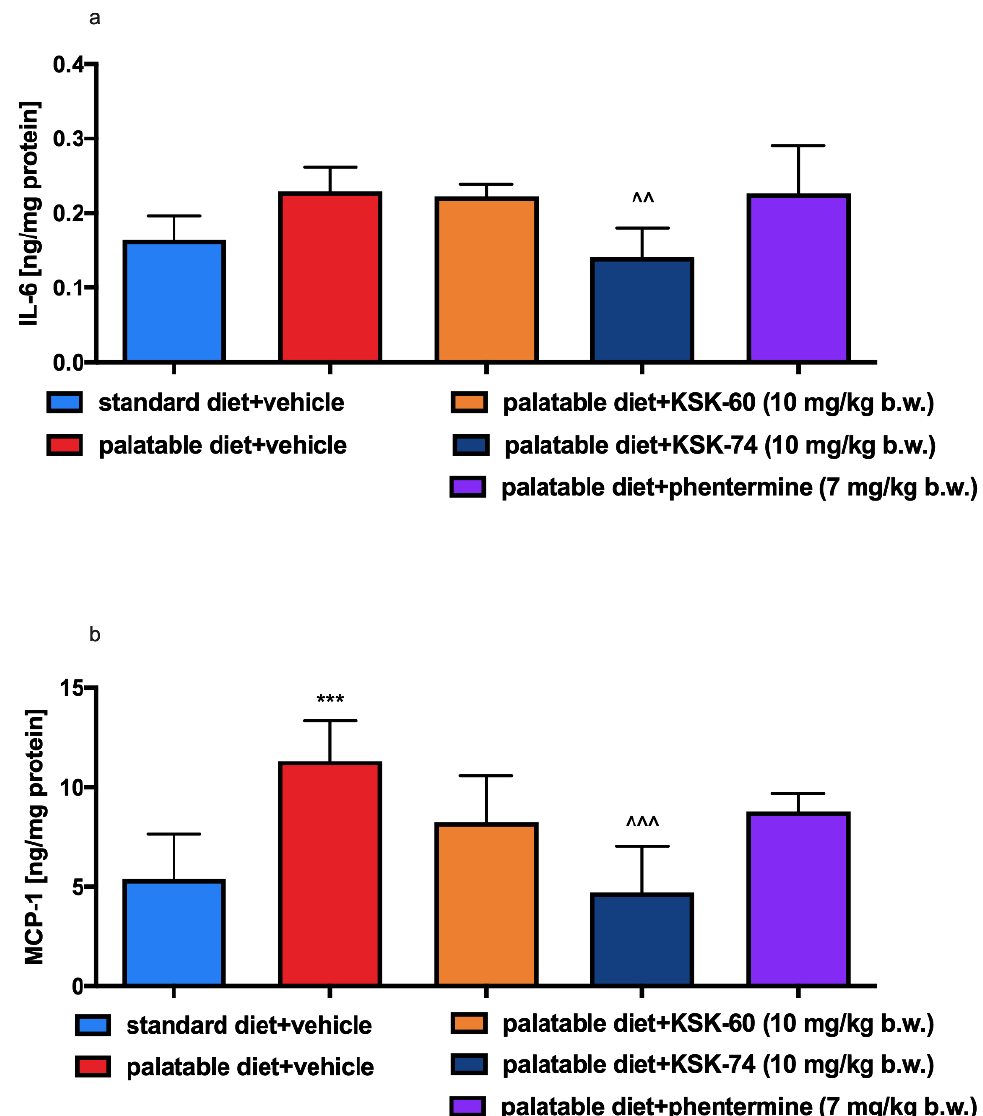
Figure 10. Effect of administration of the tested compounds or phentermine on adipose tissue levels of ( a ) IL-6 and ( b ) MCP-1. Results are expressed as means ± SD, n = 6. Comparisons were made using one-way ANOVA, Tukey’s post hoc test; * significant vs. standard diet + vehicle group; ^ significant vs. palatable diet + vehicle group ^^ p < 0.01, ***, ^^^ p < 0.001. There were significant changes in leptin and resistin levels in adipose tissue between rats in control groups that received different diets (standard or palatable) and vehicle ( p < 0.05, Figure 11a,b). Compared to the palatable diet + vehicle group, reduced levels of leptin and resistin were observed in adipose tissue from animals that received i.p. KSK-74 10 mg/kg ( p < 0.001, p < 0.01, Figure 11a,b). Phentermine did not influence the concentration of leptin or